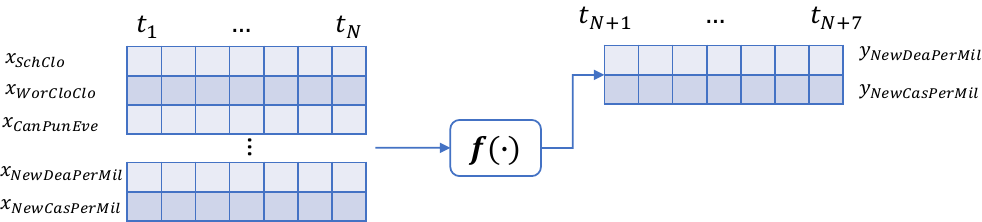
Figure 1. A non-linear sequential model to predict daily confirmed cases and deaths due to the COVID-19